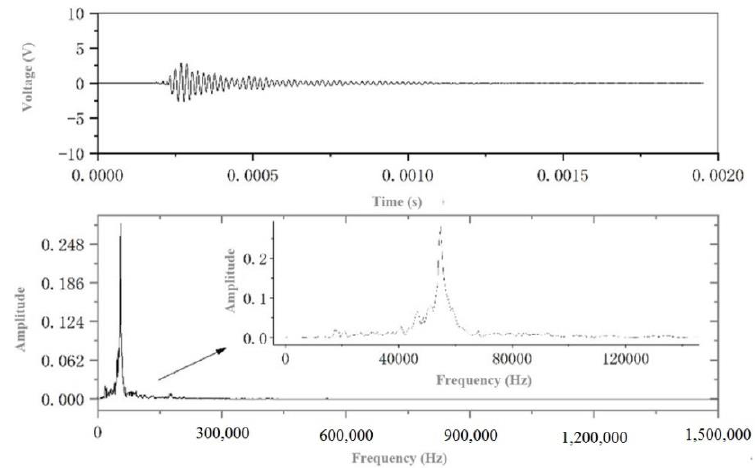
Figure 8. Spectrogram of non-broken wire acoustic emission signal.